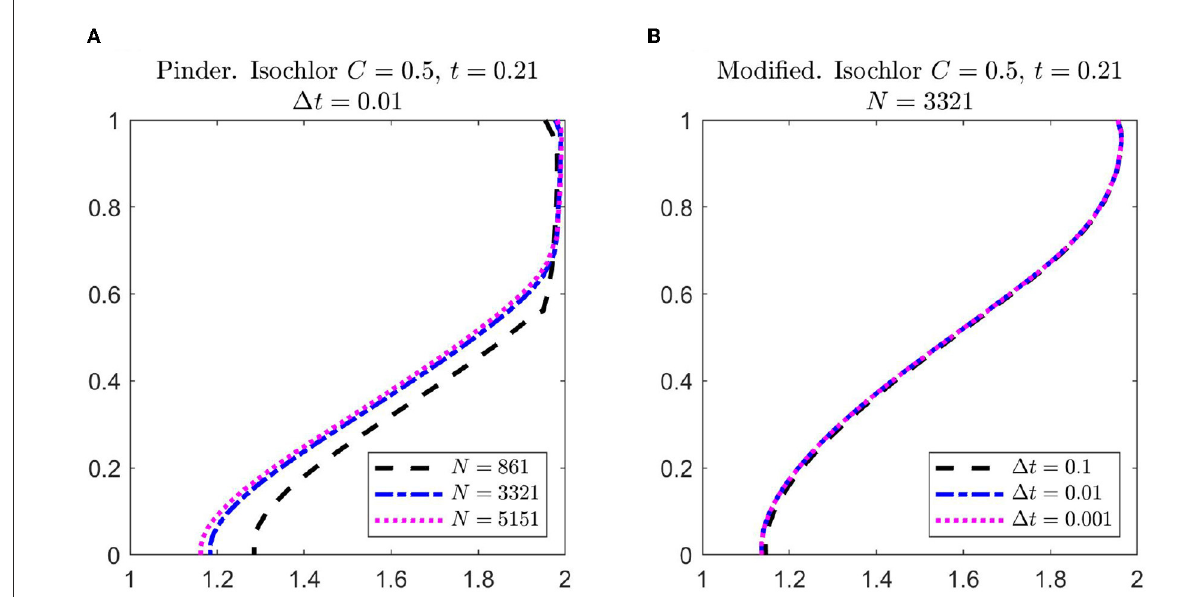
FIGURE11 (A) Isochlor C = 0.5 for the Pinder version of Henry problem ( a = 0.2637, b = 0.035), using different number of total nodes, N = 41 × 21 = 861, N = 81 × 41 = 3,321, and N = 101 × 51 = 5,151. (B) Isochlor C = 0.5 for the modified Henry problem ( a = 0.1315, b = 0.2), using different time increments, 1 t = 0.1, 1 t = 0.01, 1 t =